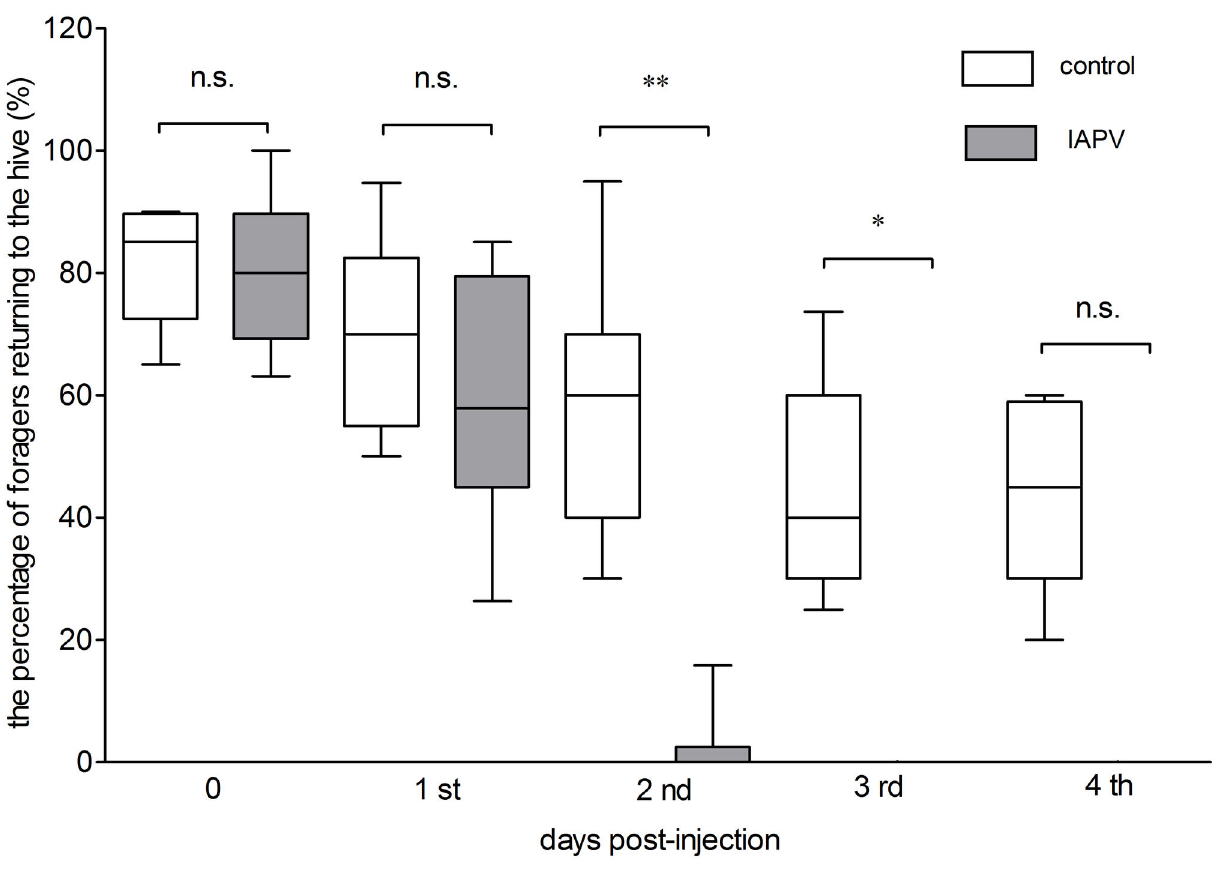
Figure 5. Effects of IAPV on the homing ability of forager honey bees. The abscissa represents days after foragers were injected with PBS and IAPV respectively. The ordinate represents the percentage of foragers departing and returning to the hive per day. *=p<0.05, **=p<0.01, n.s.= not significant. Error bars show